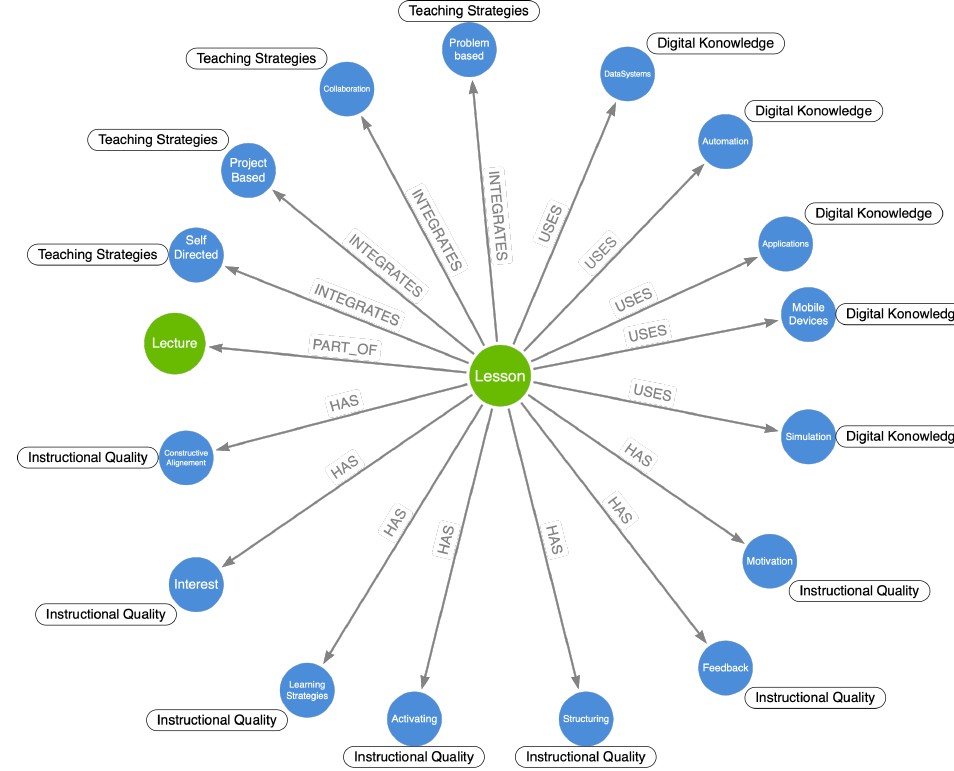
Figure 5. Model of the graph